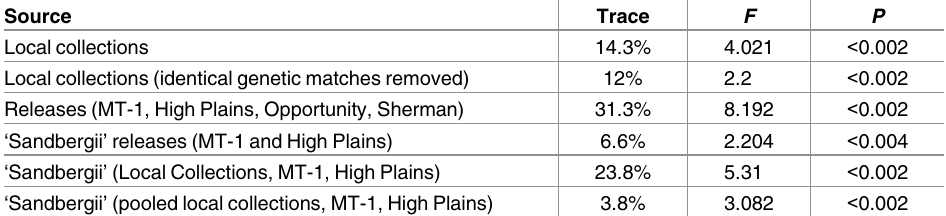
Table 3. Distance-Based Redundancy Analysis (DB-RDA) results by category.